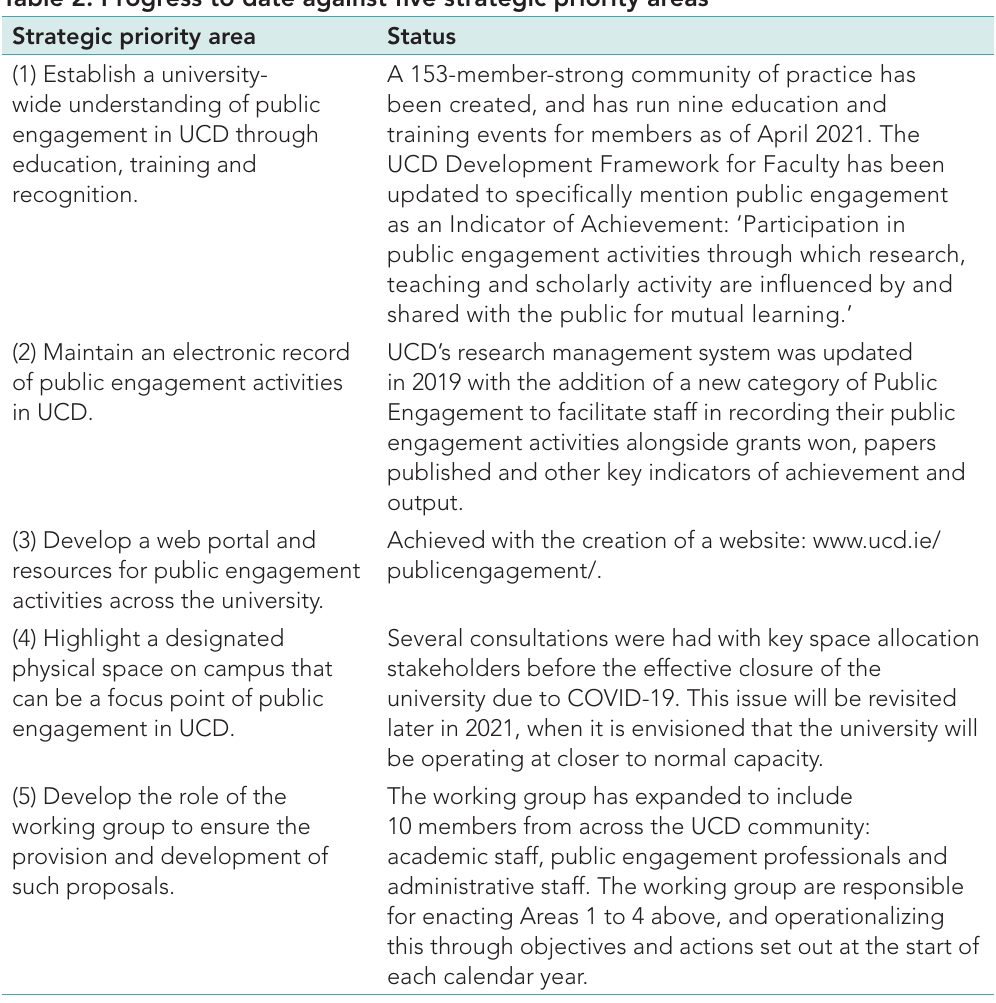
Table 2: Progress to date against five strategic priority areas strategic priority area